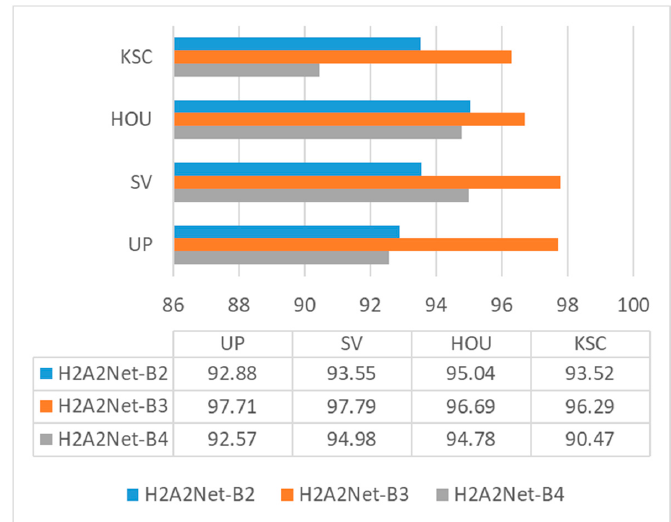
Figure 15. OAs (%) under different branches in the